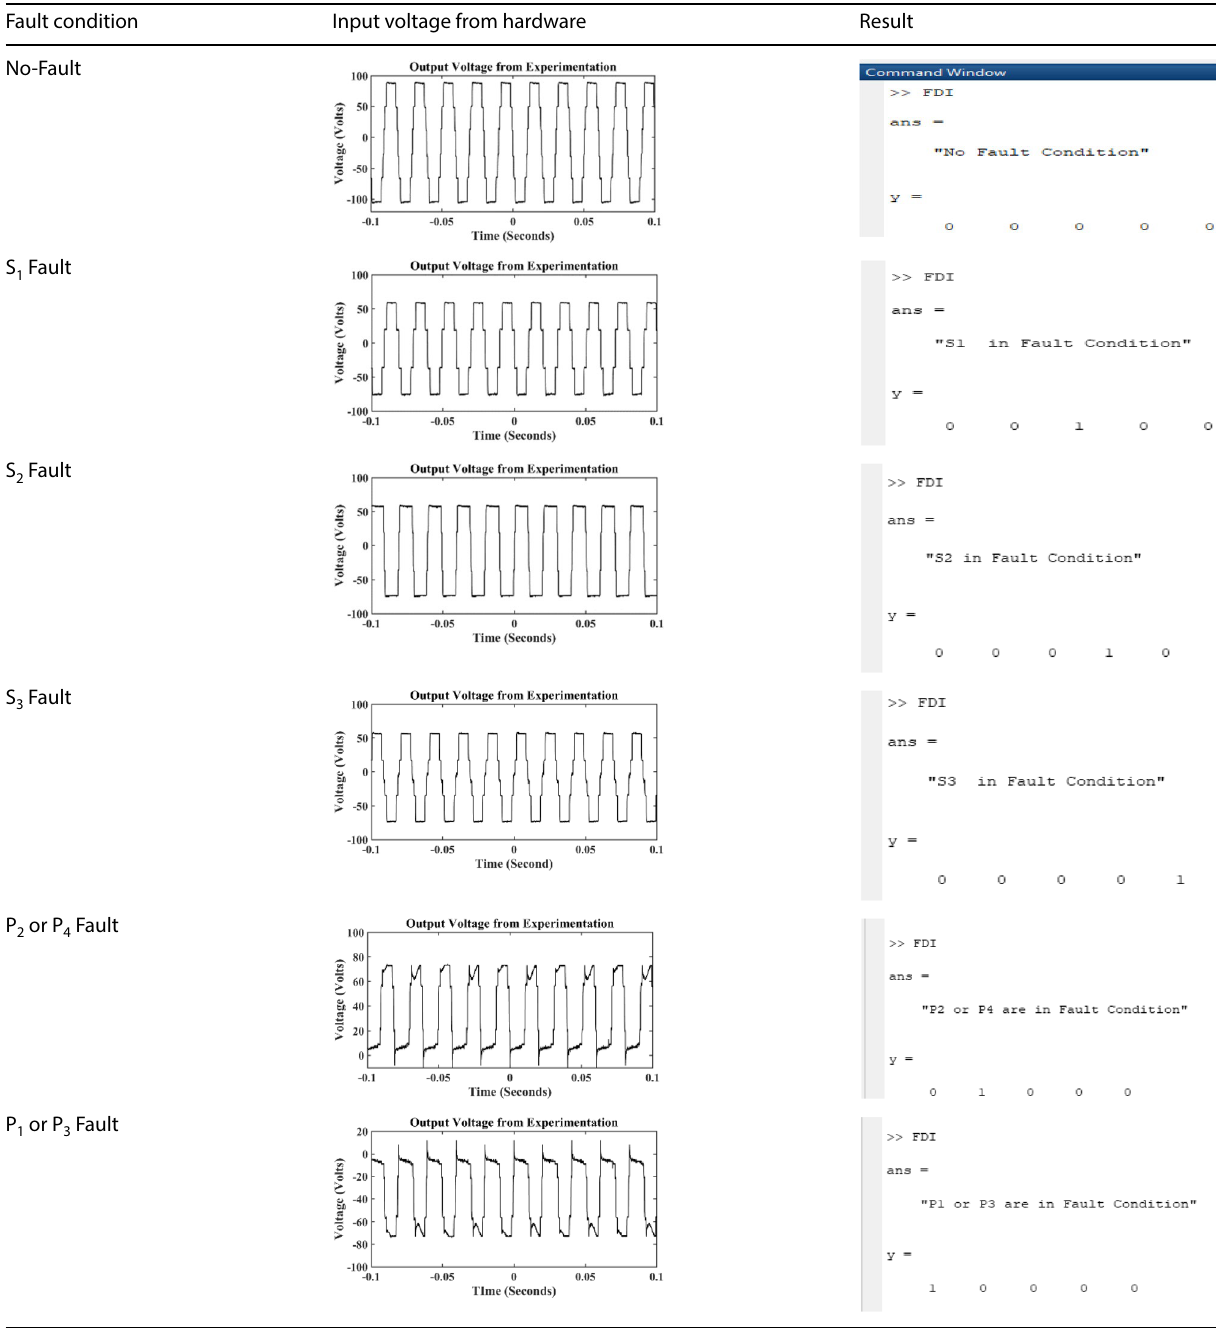
Table 6 Validation of fault detection algorithm from experimental results Fault